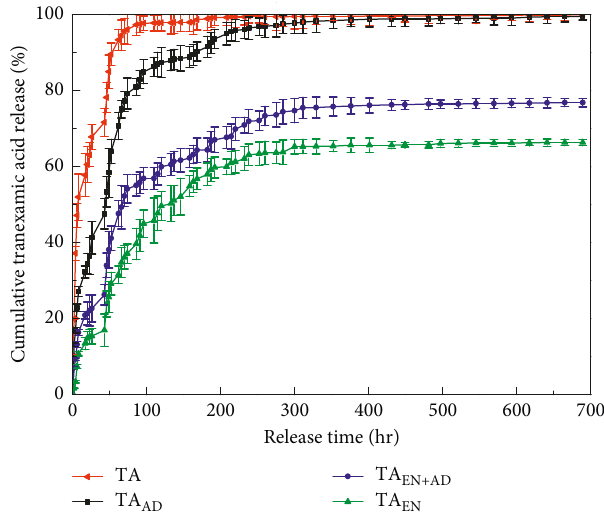
Figure 2: Kinetic release behaviors of tranexamic acid in various emulsified